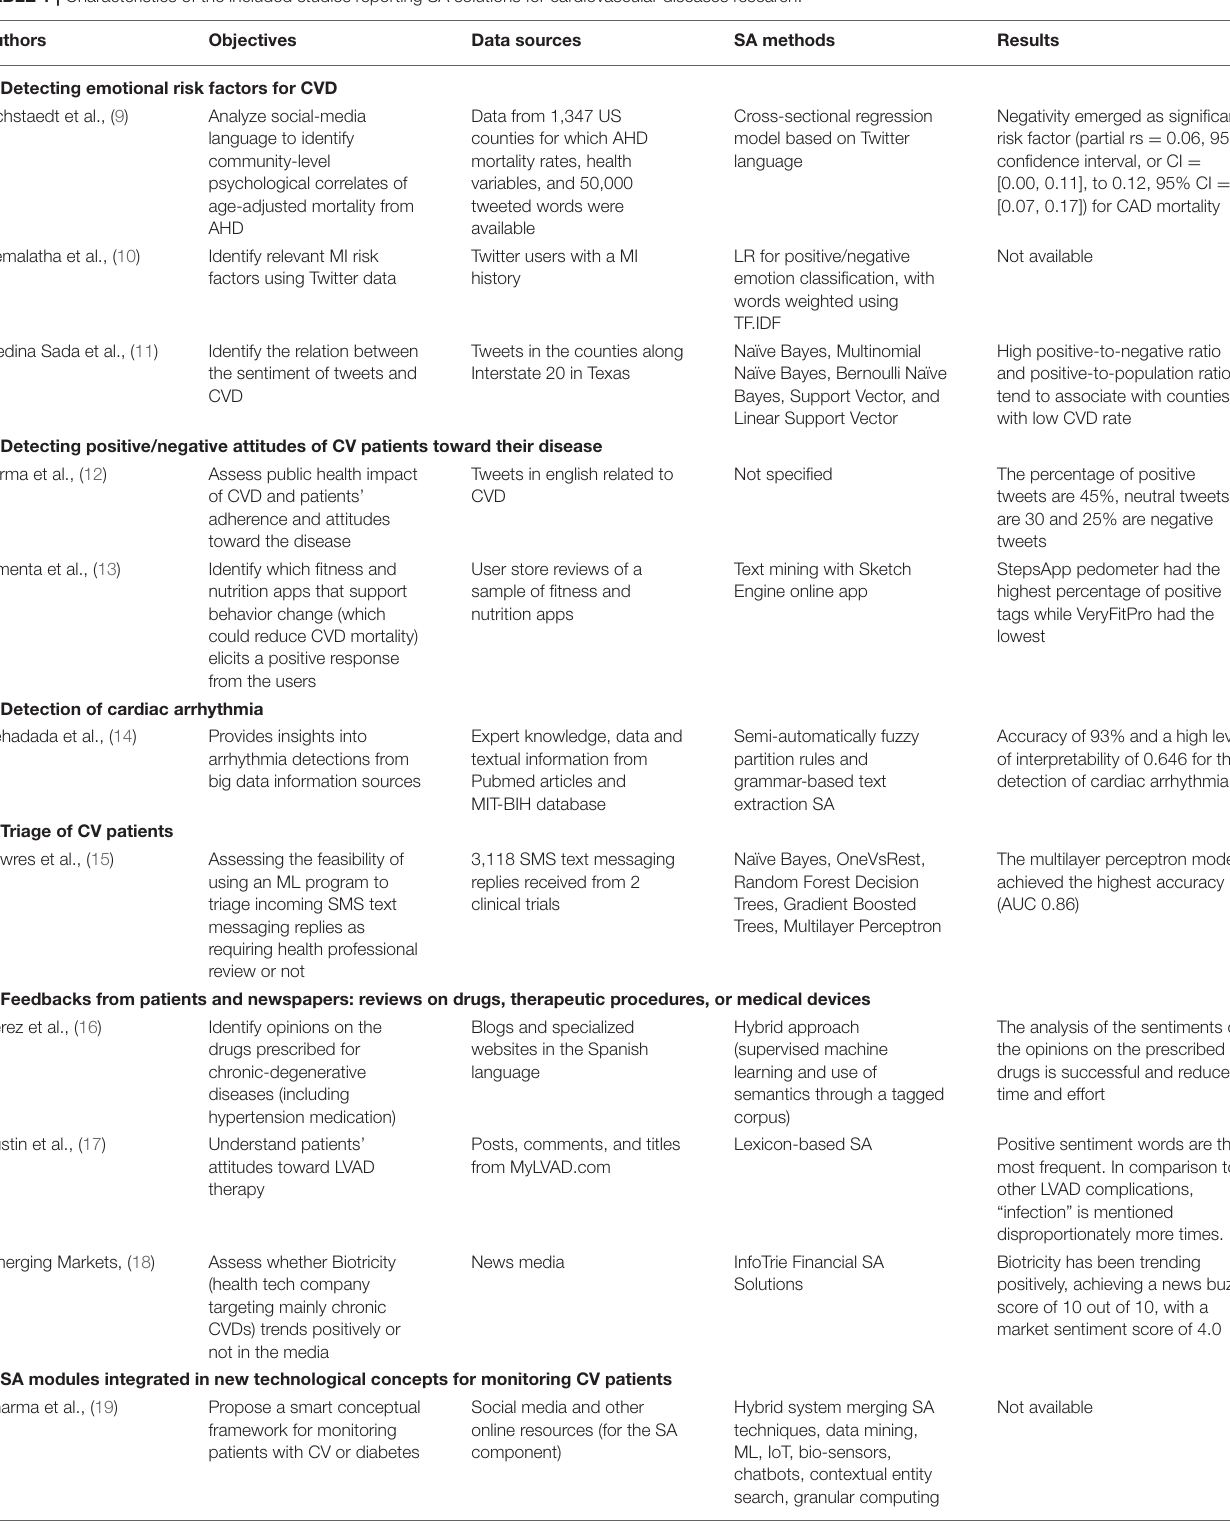
TABLE 1 | Characteristics of the included studies reporting SA solutions for cardiovascular diseases